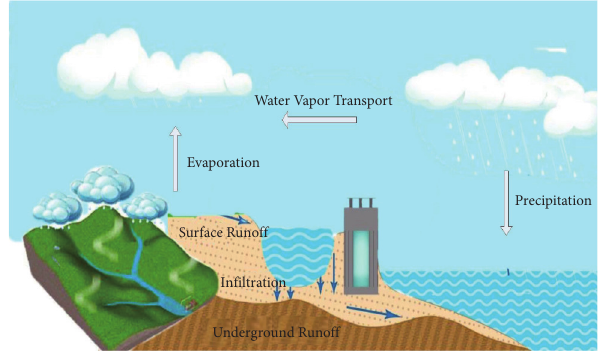
Figure 1: The schematic diagram of hydropower station inflow.